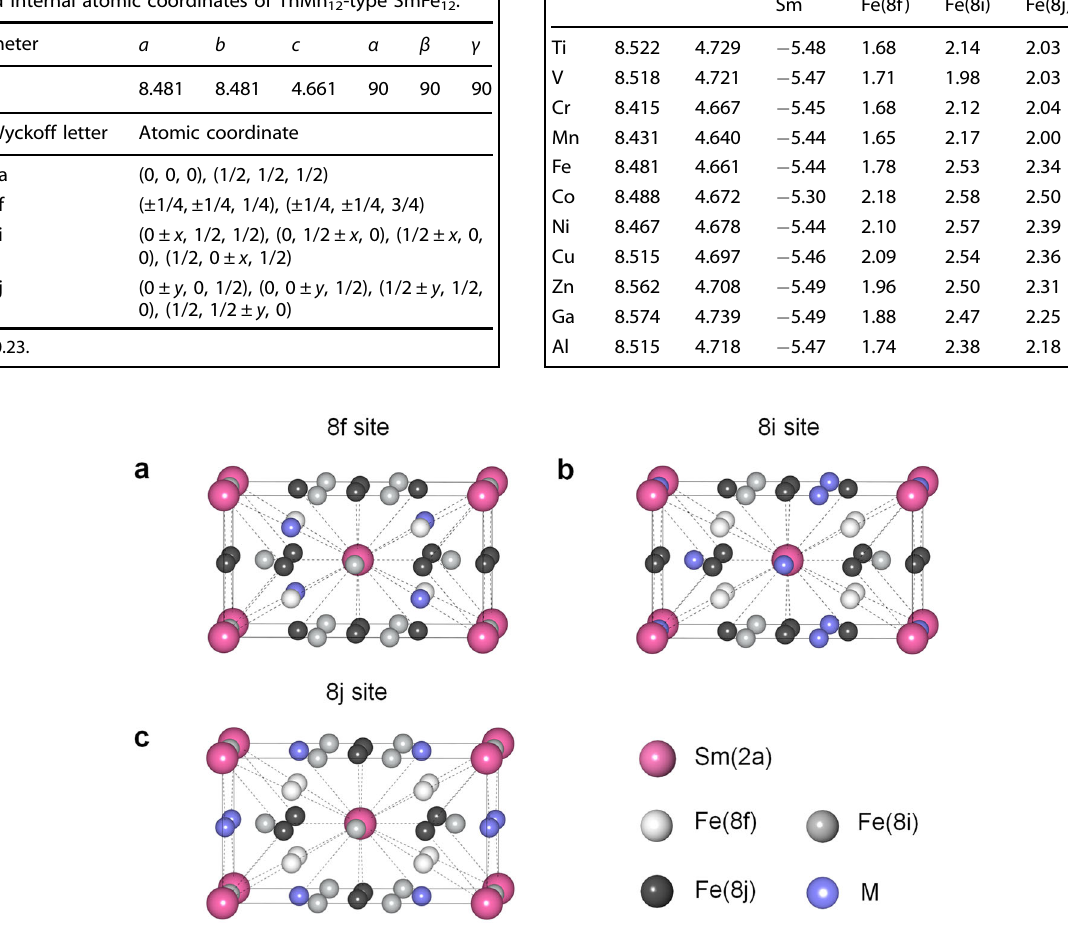
Table 1. Optimized lattice parameters a , b , and c ( Å ), and angles α , β , and γ ( ∘ ), and internal atomic coordinates of ThMn 12 -type SmFe 12 .